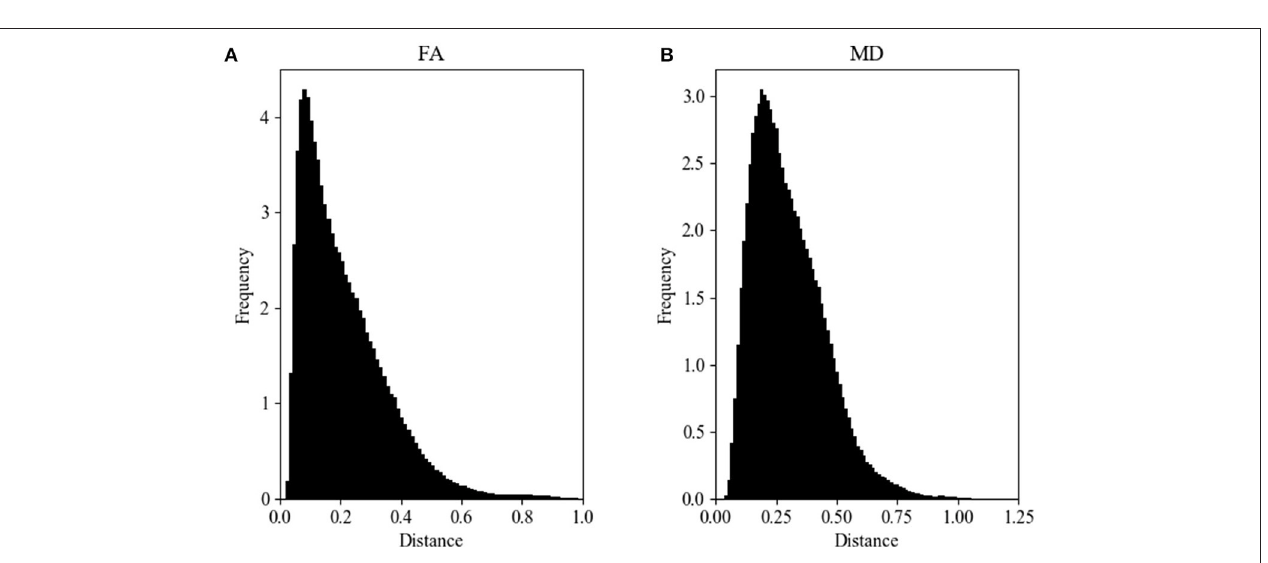
according to the Mann–Whitney U ( U = 8.5e9, p =